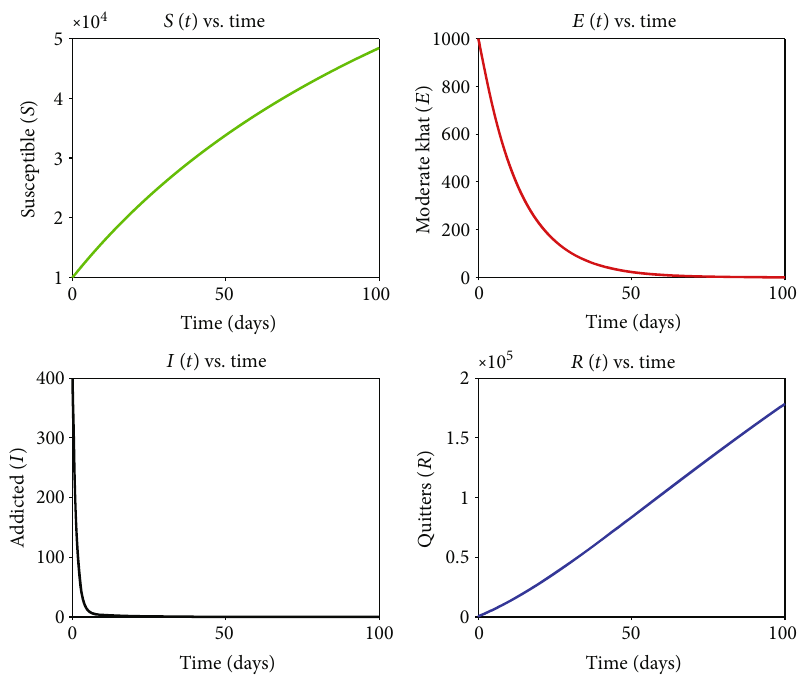
Figure 2: Time series plot of state variables for R